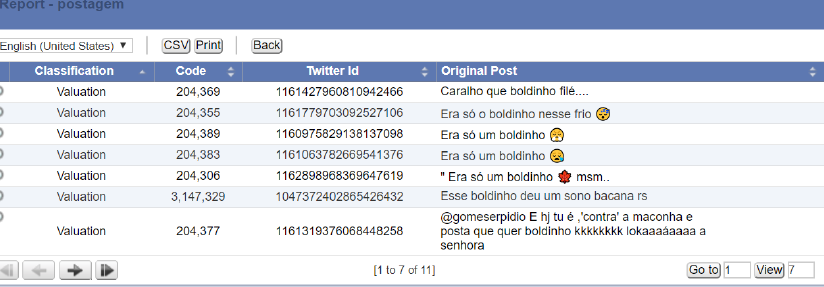
Figure 8. Search result report interface of the SocCrime